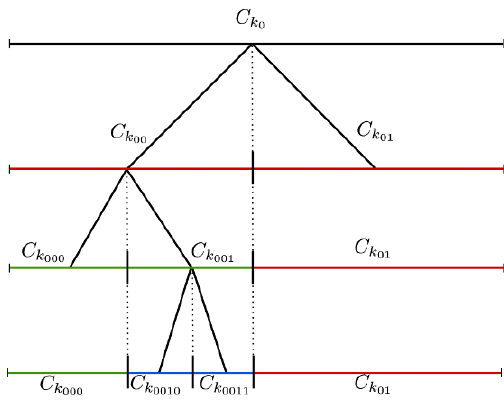
Figure 1. Example of the hierarchical dyadic tree.